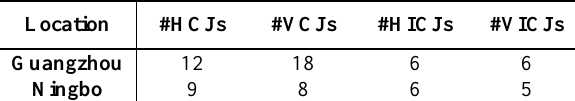
Table 2. The matching accuracy of the junctions in Figure 8.